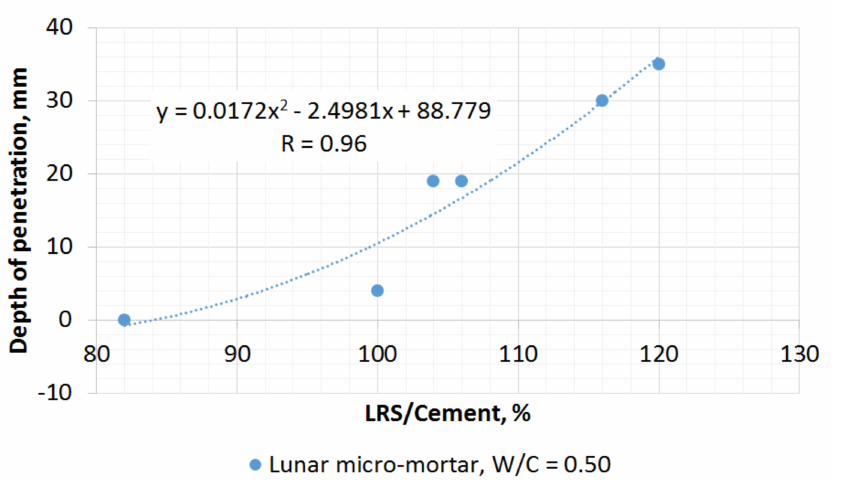
Figure 6. The consistency of lunar micro-mortars of w/c = 0.50 expressed by the depth of penetration in the Vicat apparatus (depth is the distance between the intender and the bottom of the Vicat ring; the ring high is 40